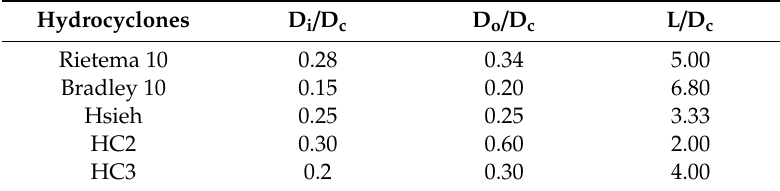
Table 7. Geometric comparison of hydrocyclone designs.